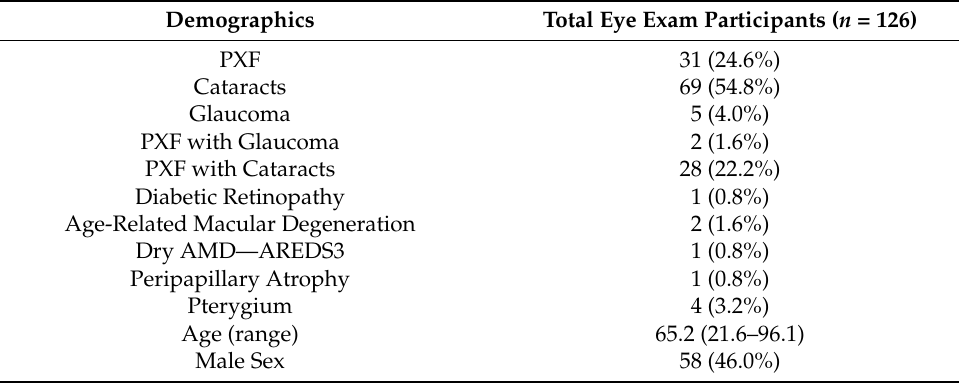
Table 1. Demographics in the eye examination study participants.